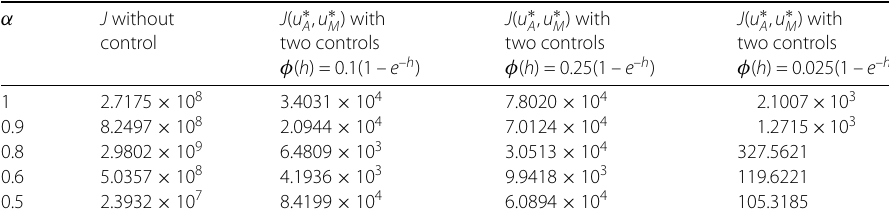
Table 1 Comparisons between objective functional values using N2LIM with and without control cases and T f = 100